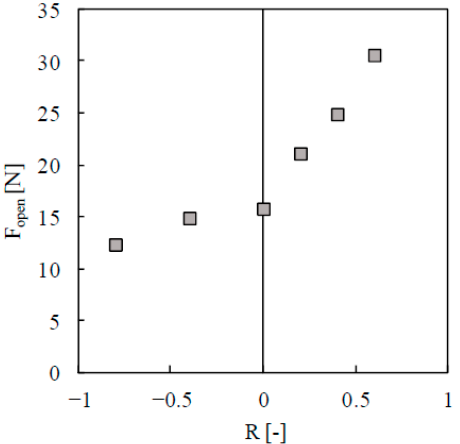
Figure 7. Crack opening load versus stress ratio, R for the loading cases with fixed maximum load ( F max = 50 N).